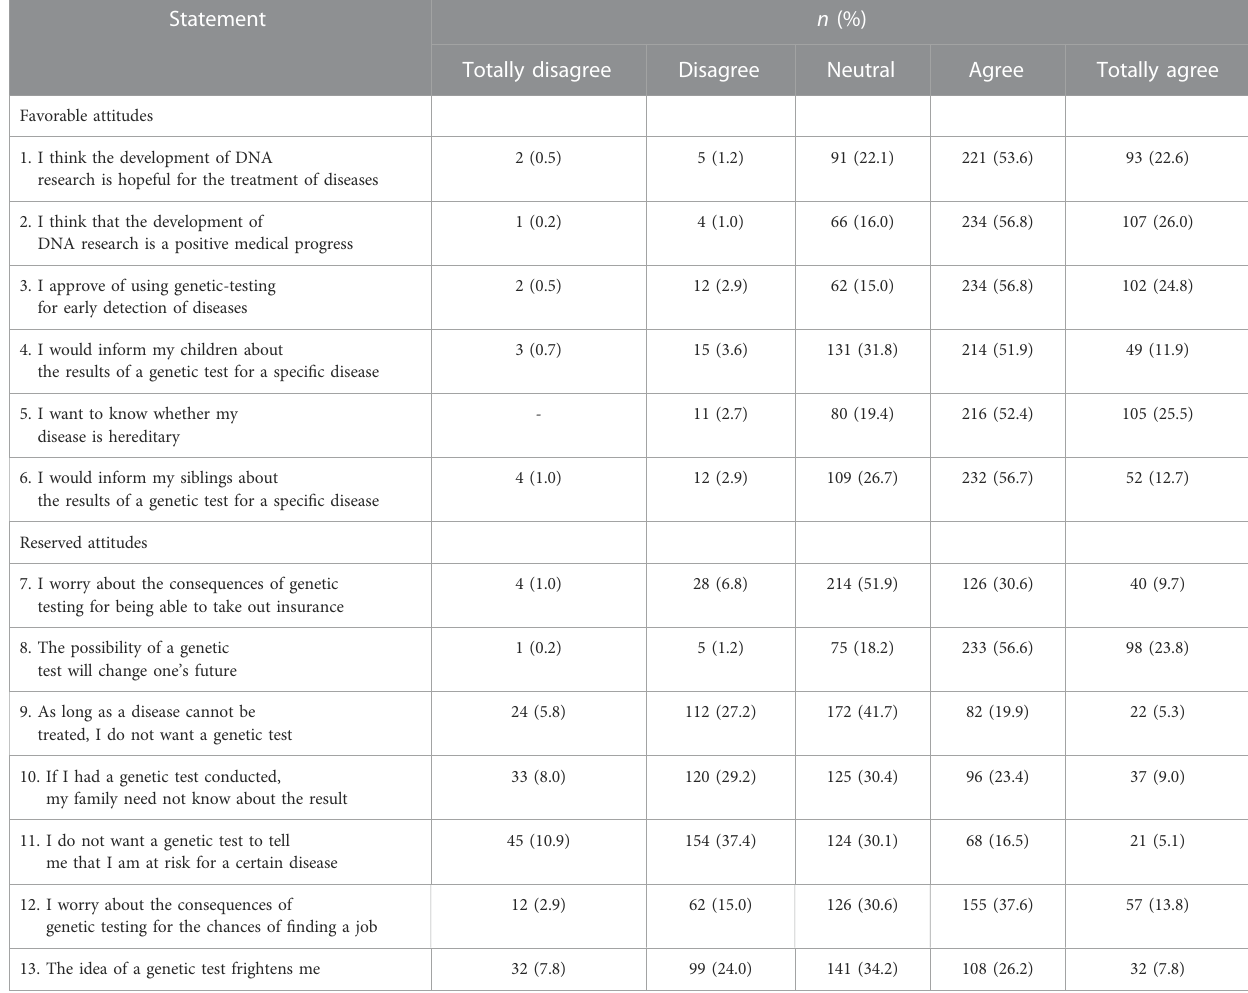
TABLE 7 Participants ’ percentage response pertaining to attitudes toward genetic